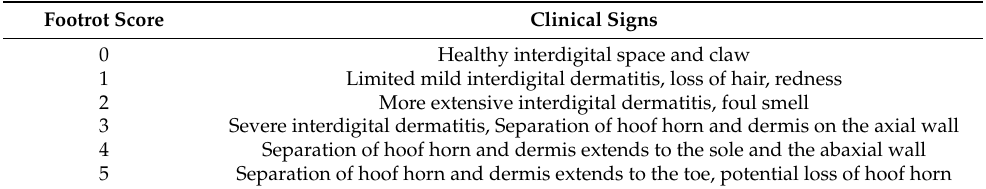
Table 3. Scoring system applied with the corresponding clinical findings